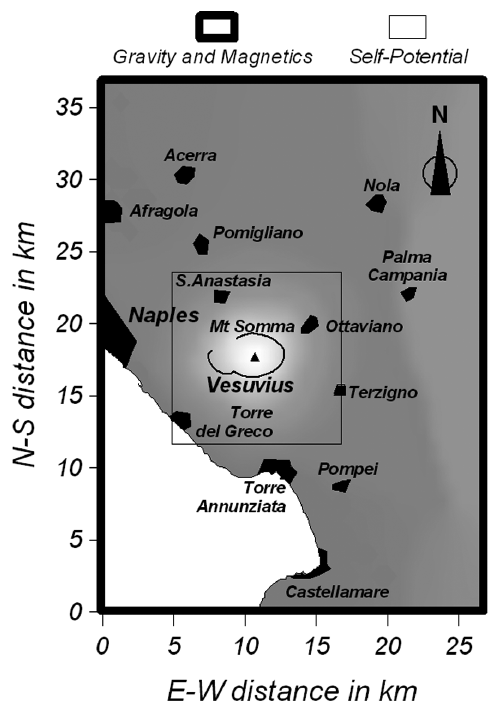
Fig. 2. A geographical sketch map of the Mt. Vesu- vius volcanic area with indication of the gravity, magnetic and self-potential surveyed